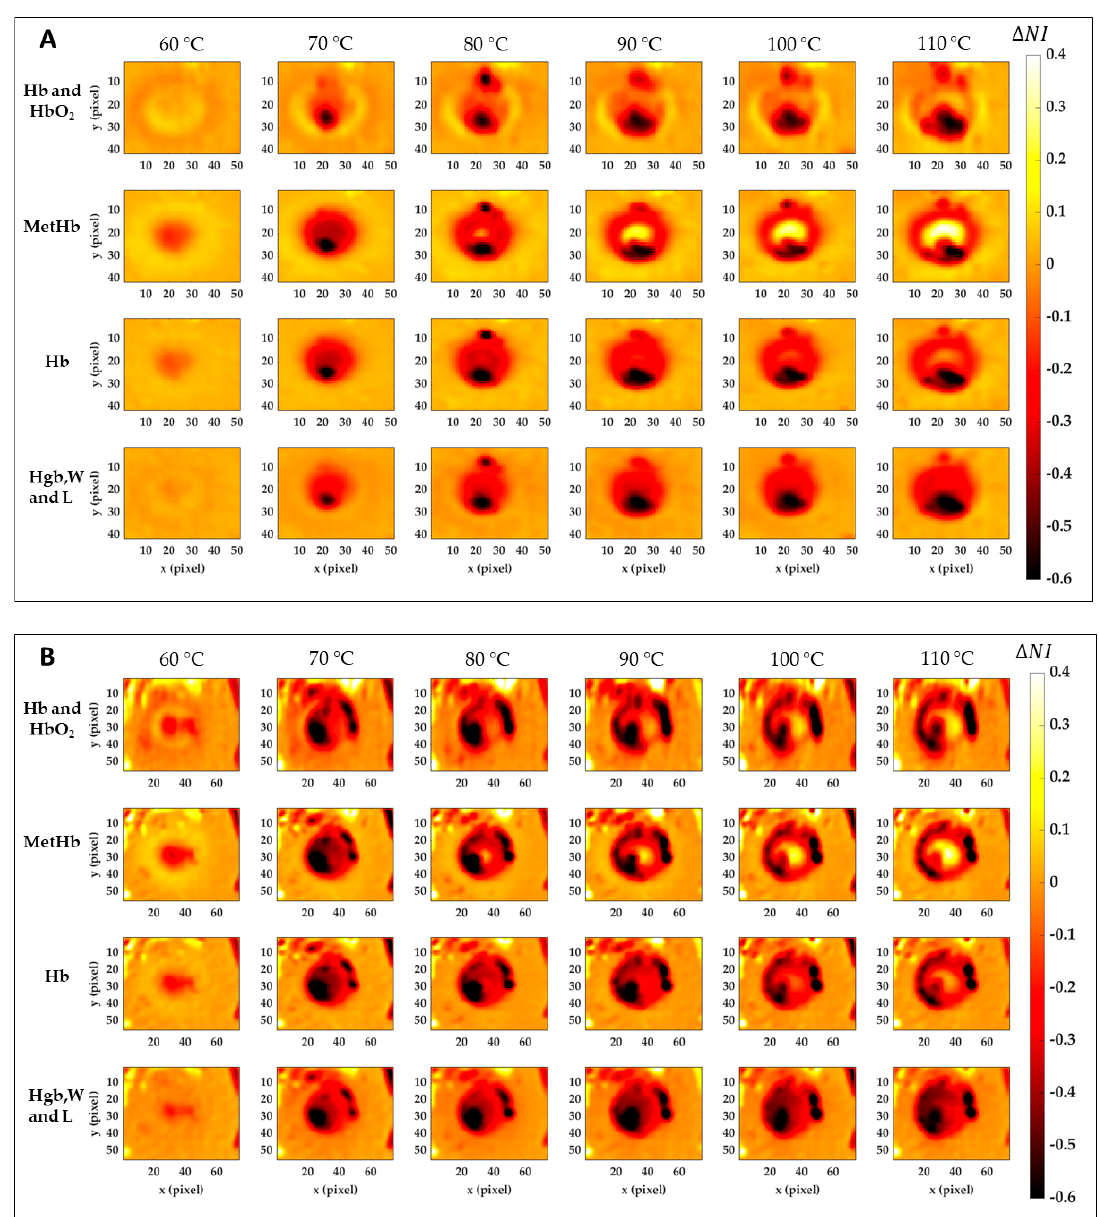
Figure 8. Normalized image variation for the four peculiar spectral ranges corresponding to Hb and HbO 2 , MetHb, Hb, and Hgb, W and L. Images are obtained with respect to the initial condition for Test 1 ( A ) and Test 2 ( B ) for the six temperature thresholds.